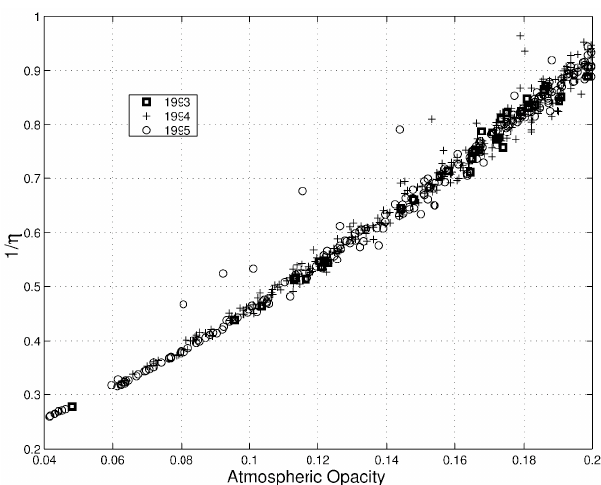
Fig. 2. Variation of the factor (1 /η ) with the atmospheric opacity for the 1-MHz